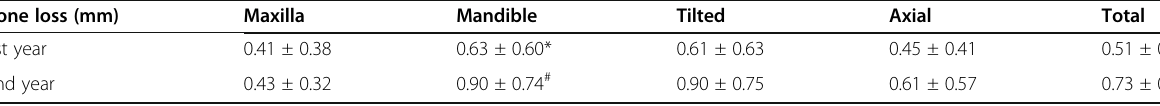
Table 3 Marginal bone loss of implants Bone loss (mm)